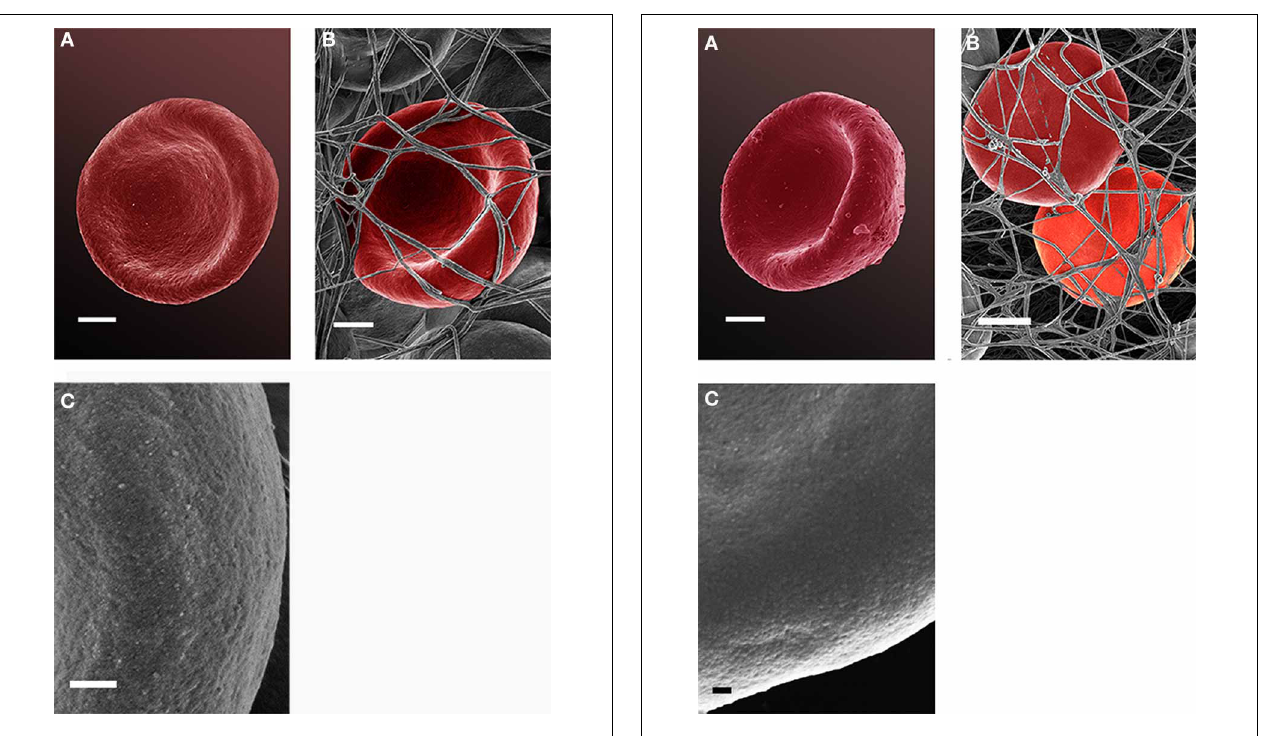
FIGURE 5 | Scanning electron microscopy (SEM) micrographs of a typical healthy red blood cell (scale = 1 µ m) (A) . RBC that is discoid in shape when thrombin is added to whole blood (scale = 1 µ m) (B) ; high magnification of RBC membrane, showing globular structure; (C) (Scale = 100nm).